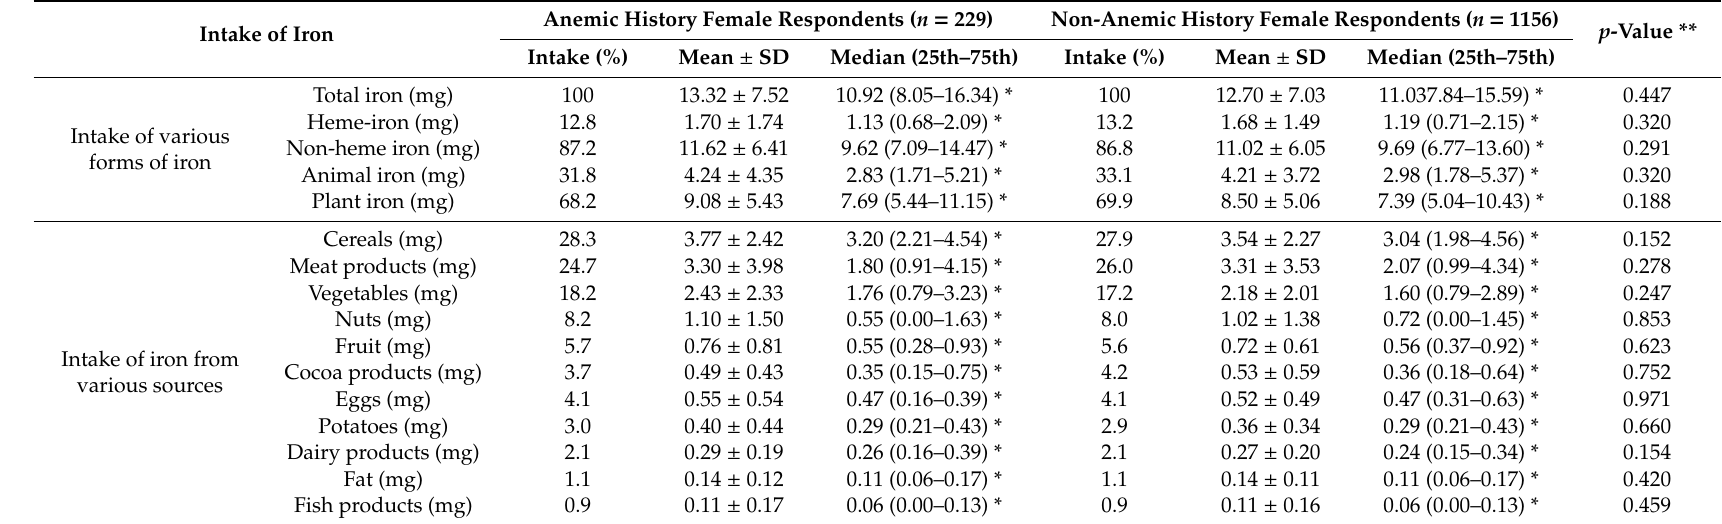
Table 5. Comparison of the intake of various forms of iron along with that of iron intake from various sources in the national sample of Polish female adolescents, in the sub-groups of anemic history and non-anemic history female